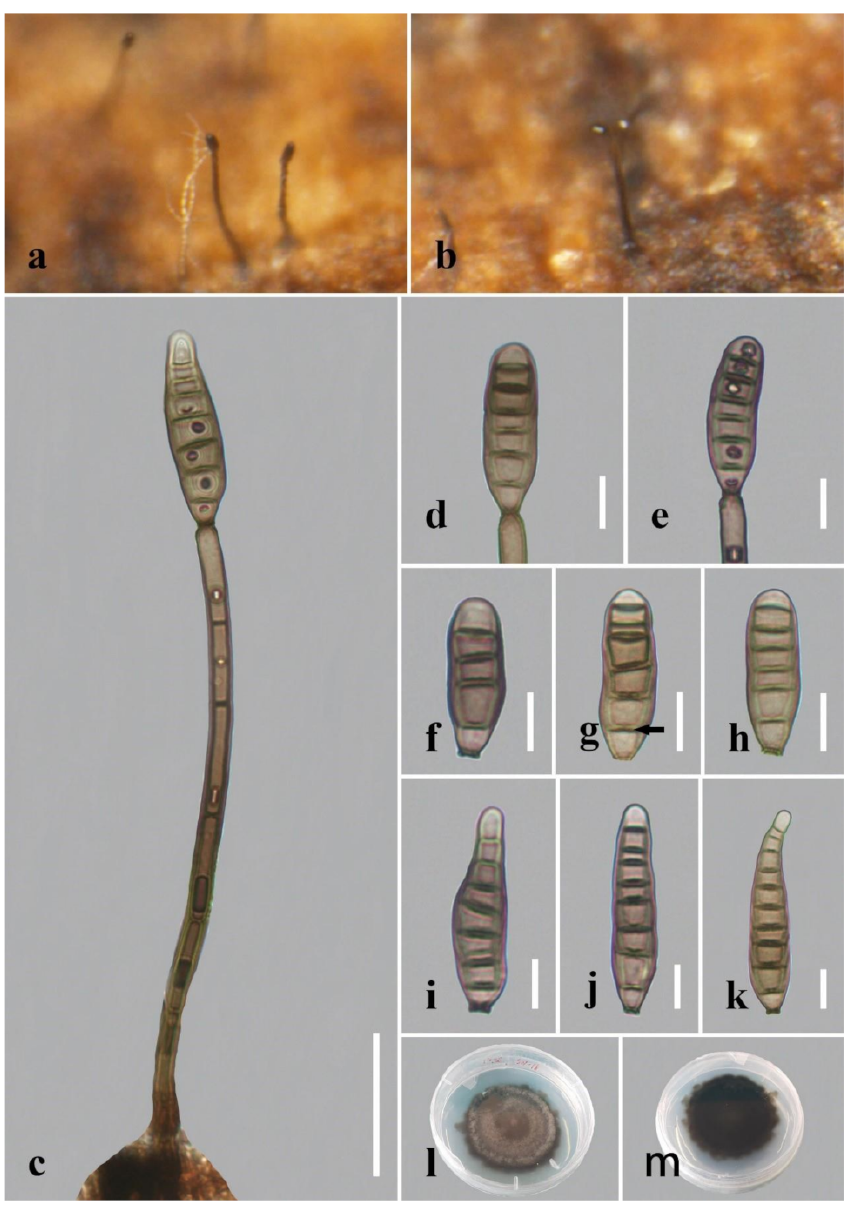
Figure 12. Distoseptispora nonrostrata (HKAS 122185, holotype). ( a , b ) Colonies on natural substrate. ( c ) Conidiophore with conidium. ( d , e ) Conidiogenous cells bearing conidia. ( f – k ) Conidia. The arrow in g points to a gap in the middle of the septum, which indicates the distosepta. ( l ) Colony on PDA (from front). ( m ) Colony on PDA (from reverse). Scale bars: ( c ) 30 µ m; ( d – k ) 10 µ